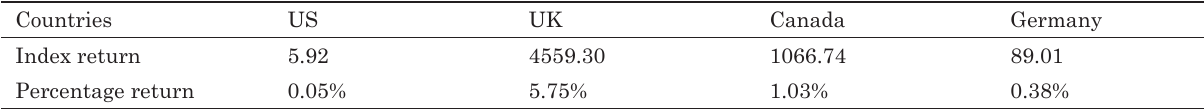
Table 4. The return of the securitized real estate indices of the four countries by the trading strategy according to the Shiryaev-Zhou index